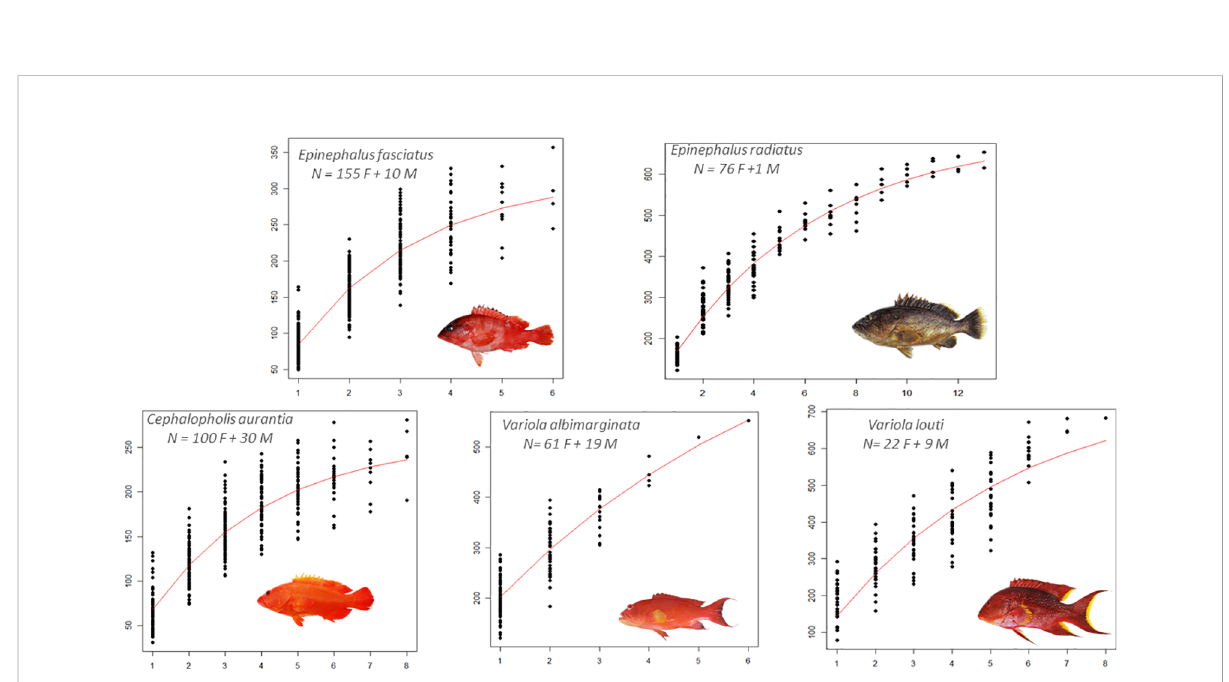
FIGURE 3 Growth curves of grouper species around La Re ́ union Island fi tted to all individual length-at-age modi fi ed back calculation method [The specimen number (N) is represented with the females (F) and the males (M) ].